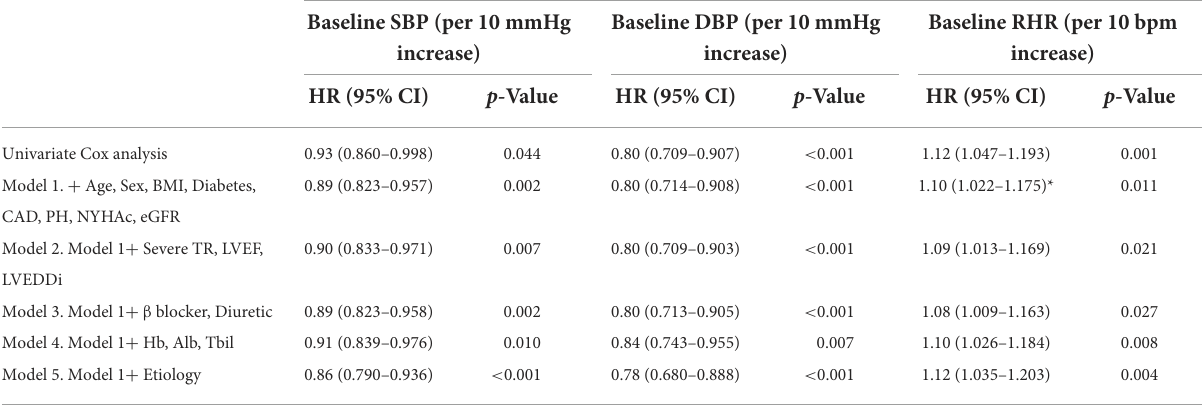
TABLE 2 Associations of SBP, DBP and RHR With All-Cause Mortality. Separate models for all-cause mortality; N = 2,013, 165 deaths